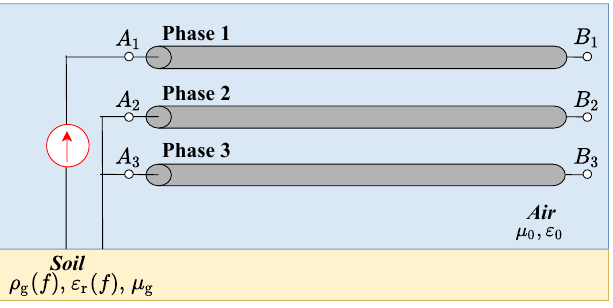
Figure 14. Lightning striking at phase 1 for an open-circuit receiving